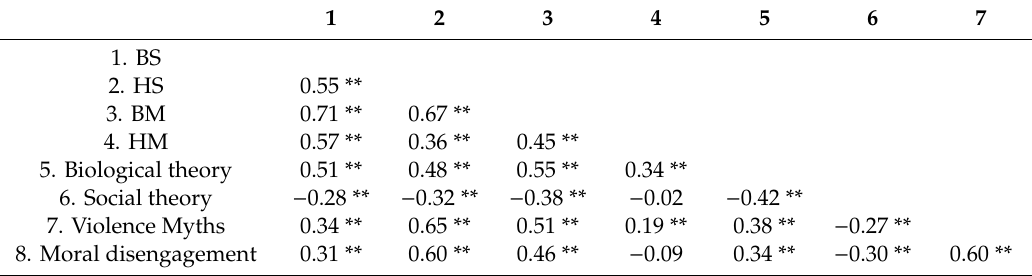
Table 2. Pearson’s correlations between study variables.